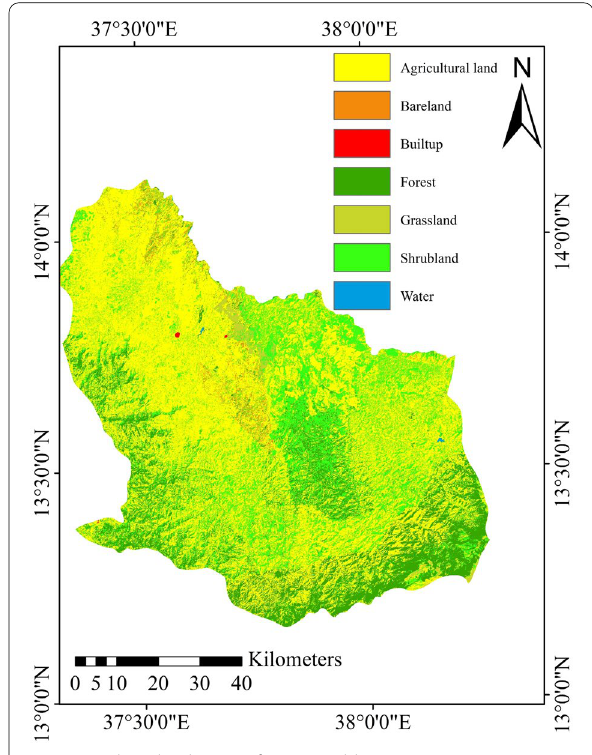
Fig. 3 Land use land cover of Zarima